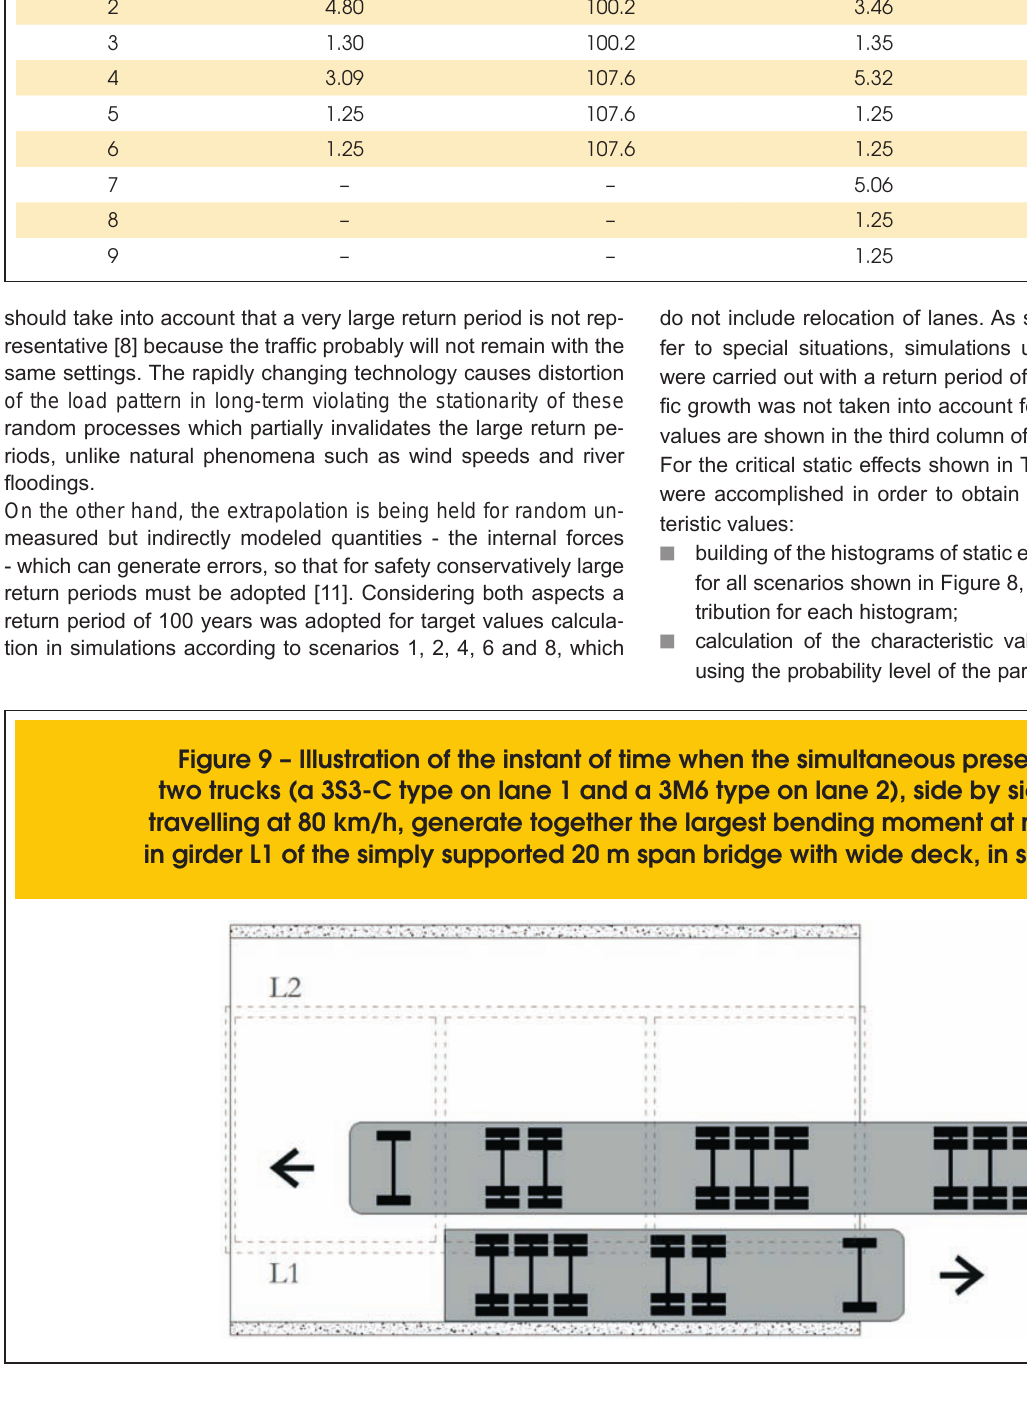
Table 9 – Wheelbases d